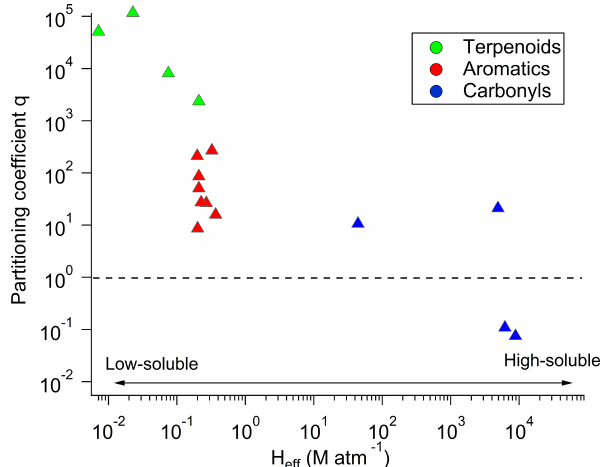
Figure 9. OVOC/VOC q factors averaged for all the cloud events and classified as a function of their effective Henry’s law constants. Each colour represents a group of compounds, namely terpenoids (green), aromatics (red), and carbonyls (OVOCs, blue).